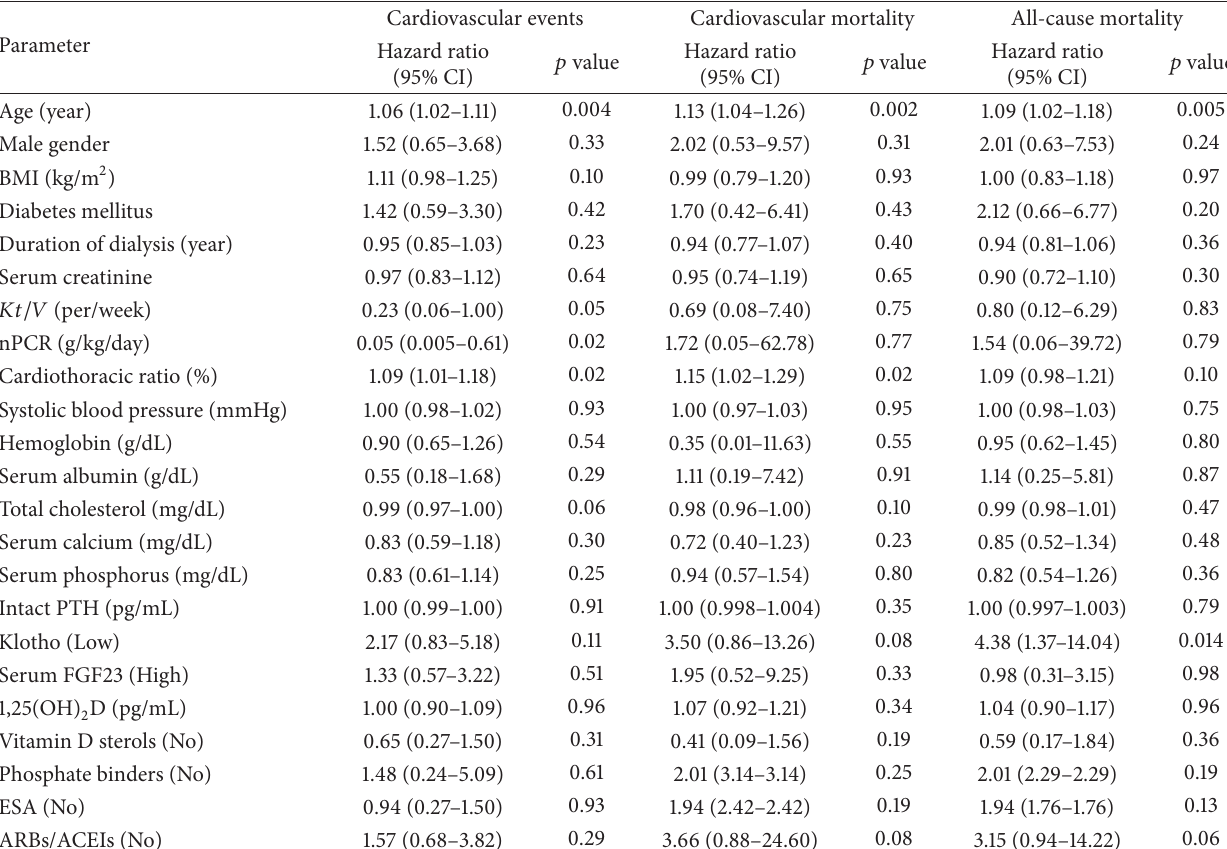
Table 2: Univariate Cox regression analyses of cardiovascular events, cardiovascular mortality, and all-cause mortality.